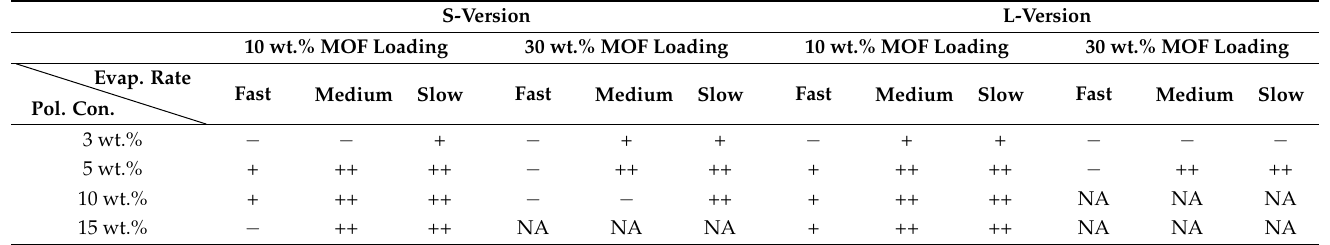
Table 1. Visual assessment of THF-based MMMs prepared with different combinations of synthesis parameters 1